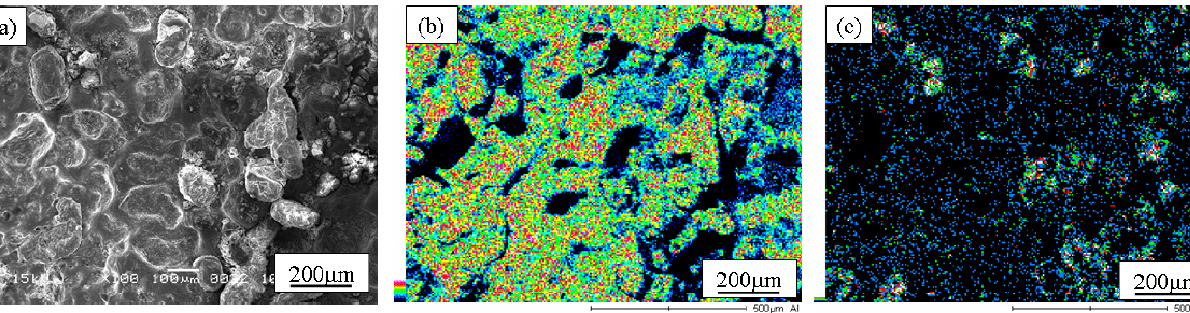
Figure 14. SEM microstructure, Al and Ti distribution maps on outer surface of the Specimen B [16].